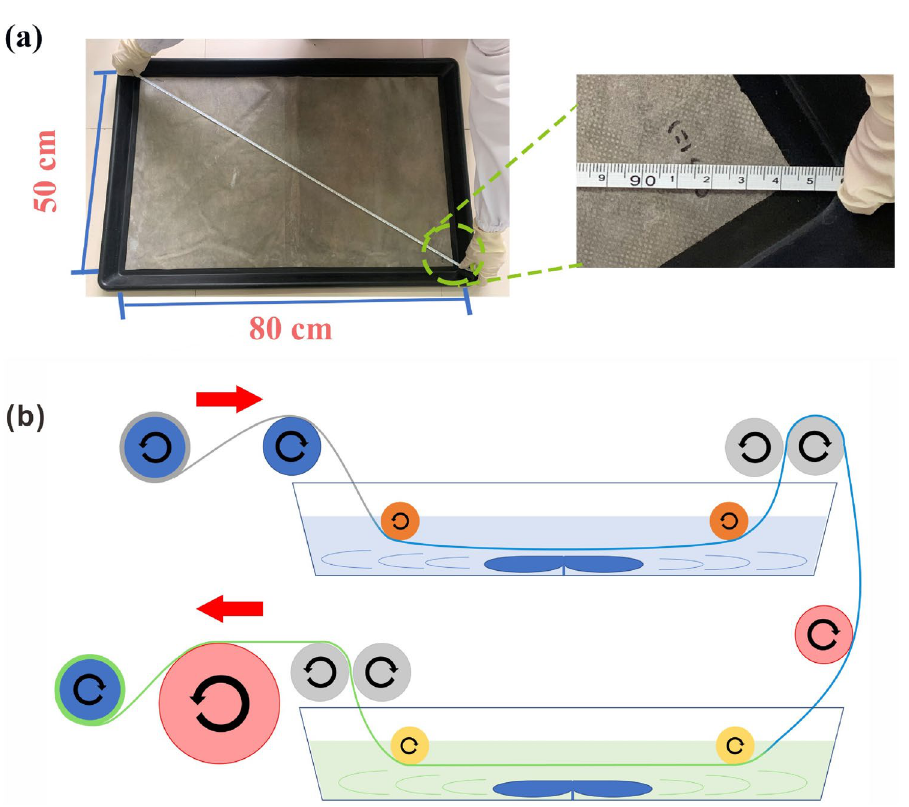
Figure 8. Schematic diagrams showing the fabrication of large-size target product ( a ) and the roll-to-roll production process of Ag/PVA/PP nonwoven fabric ( b